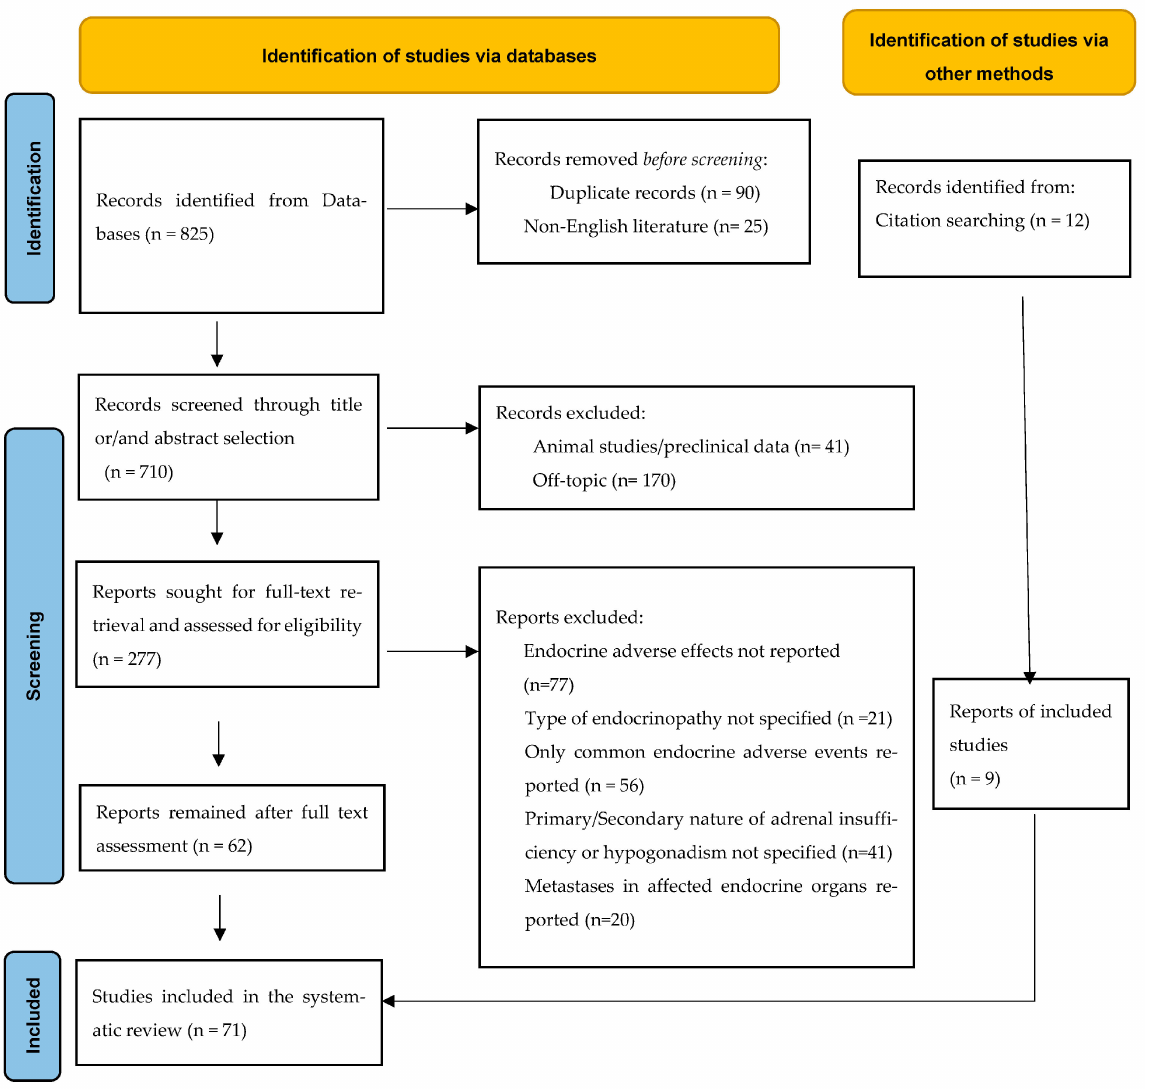
Figure 1. Flow diagram of the literature search strategy, according to the Preferred Reporting Items for Systematic Reviews and Meta-analyses (PRISMA) 2020